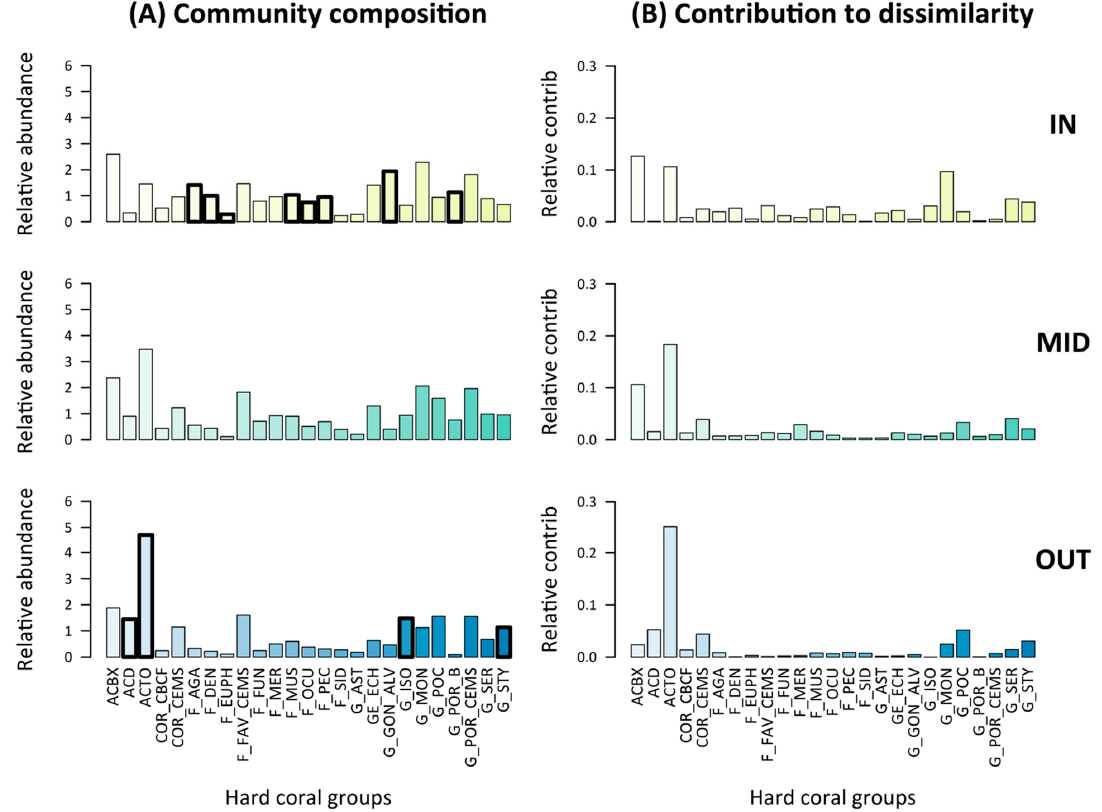
Figure 4. Composition of pre-disturbance hard coral communities ( A ) and relative contribution of taxon to community dissimilarity (i.e., either disassembly or reassembly) following disturbance ( B